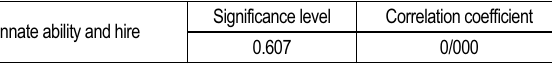
Table 3. Spearman correlation coefficient test